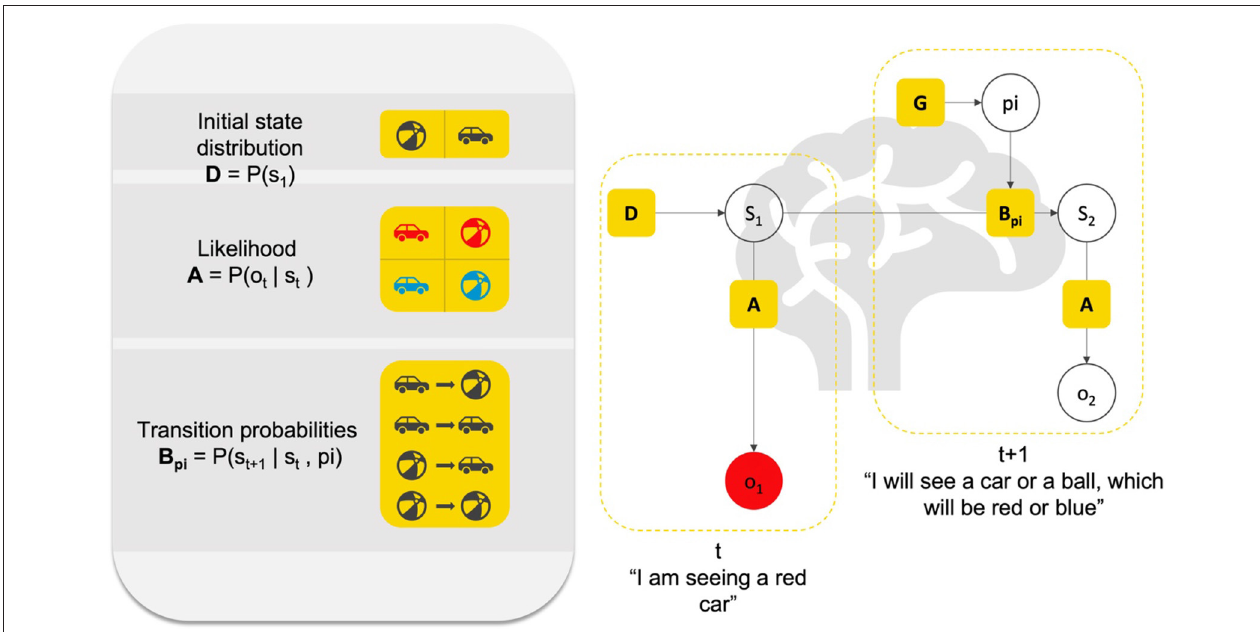
FIGURE 1 | Heuristic description of perception and action as inference. This figure presents a Bayesian graphical model of the relation between (priors and likelihood) parameters that constitute an elementary generative model for action and perception. Here, we can imagine an agent infers the cause “s” of its sensation “o” that it receives at time “1”. This inference is based on a likelihood A (P(ot|st)) about what generally causes red entries (e.g., is this a car or a ball?), and prior probabilistic knowledge about where the agent currently is in the world (e.g., am I facing a ball or a car?), or initial state D (P(s1)). Based on A and D , the agent can infer s1 (e.g., I am seeing a car). Then, assuming the agent acts based on its perception, it can further leverage knowledge about the dynamics of the world in which it exists, that is, of the transitions between different states of the world (e.g., ball to ball, ball to car, car to ball, etc.), which corresponds to probabilistic knowledge about transitions B (P(st + 1|st,pi) ). Based on A , B , and D , the agent can infer the possible courses of action “pi” to take and the future sensory outcome that it will experience (e.g., red; blue). Representations of causes in the world are hidden states denoted by “s”, representations of allowable policies are denoted by “pi”. Both must be inferred; hence they are in open white circles. Note that “o2” also has to be inferred, since policy selection (i.e., action) involves selecting the course of action toward future sensations. What is known to the agent are the parameters A, B , and D . Heuristically, perception (small L shape) rests on (implicitly) asking the question: “Given that I see ‘red’ (o1), and knowing that there is a prior probability (D) of cars and balls in this environment (e.g., open street), and knowing that both balls and cars can be ‘red’ with a given probability (likelihood A ), did a car or a ball cause me to see ‘red’?” The answer to that question is the inference in s1. In turn, action rests on